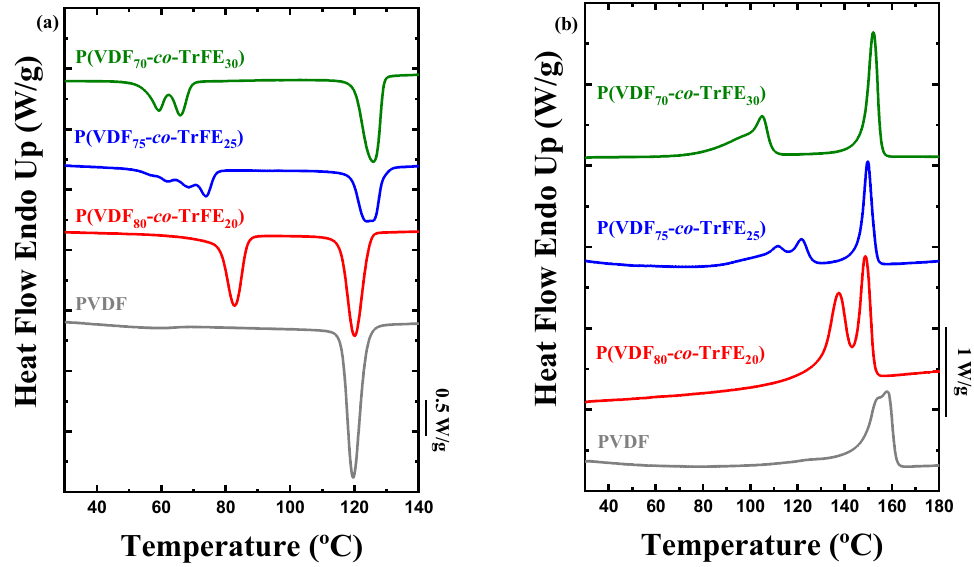
Figure 1. DSC experiments for the PVDF homopolymer and P(VDF- co -TrFE) copolymers at different compositions. ( a ) Cooling scan from the melt at 20 °C/min and ( b ) heating scan at 20 °C/min after the previous cooling process.